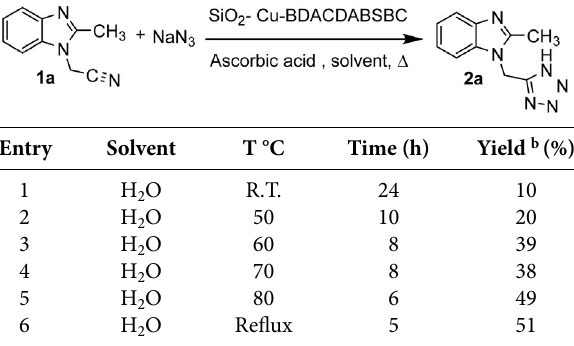
Table 1. Effect of H 2 O and temperature on [3+2] cycloaddition re- action of azide-nitrile using Cu-BDACDABSBC and ascorbic acid to afford 2a a .